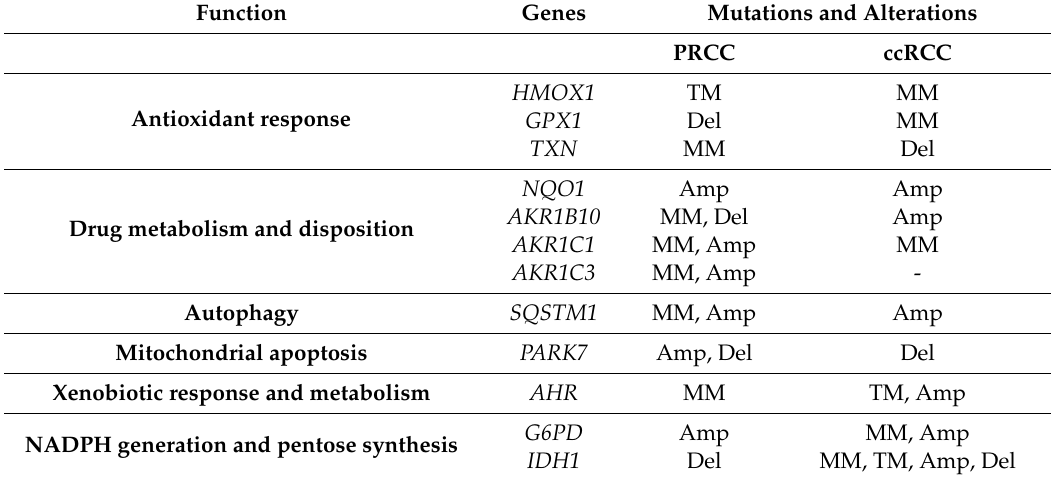
Table 1. Mutations and alterations of principal NRF2 target genes in PRCC and